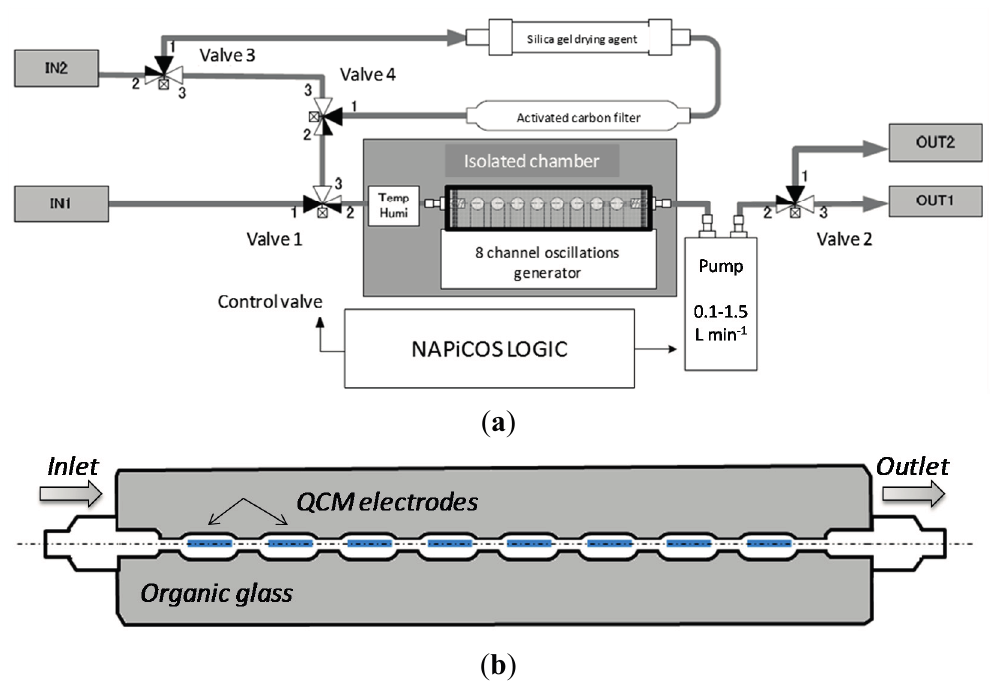
Figure 2. ( a ) Block-scheme of the prototype QCM sensor array; ( b ) Top-view of the geometry of QCM electrodes containing chamber, supporting the proper flow through all 8 electrodes independent on position in respect to